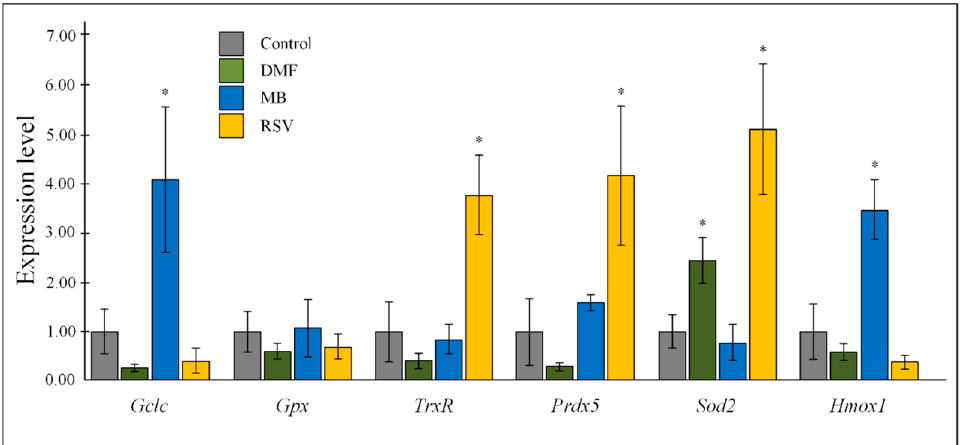
Figure 5. Expression of antioxidants in the hippocampus. The results expressed as means ± SEM. Control n = 8, DMF = 9, MB = 6, RSV = 7. * p < 0.05, comparison of the control group and treated groups using Tukey’s post-hoc test.